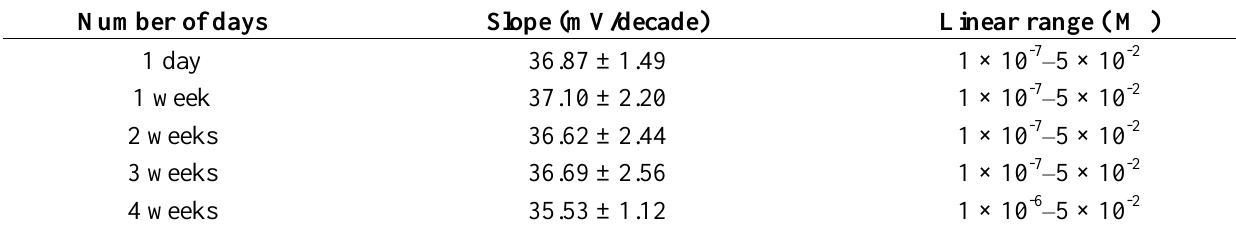
Table 2. Representing the durability of thallium (I) ion sensor